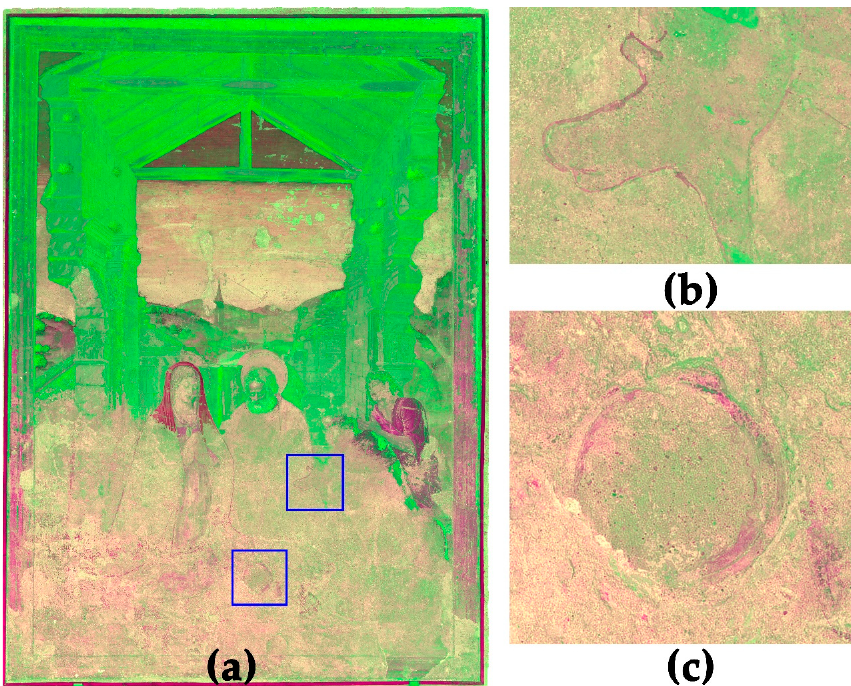
Figure 8. ( a ) Hybrid image based on the combination of PC1, 2 and 3. The image helps to localise underdrawings in the unfinished lower part of the mural; ( b ) detail of the shepherd’s hand; ( c ) contour line of the halo of the newborn baby Jesus.